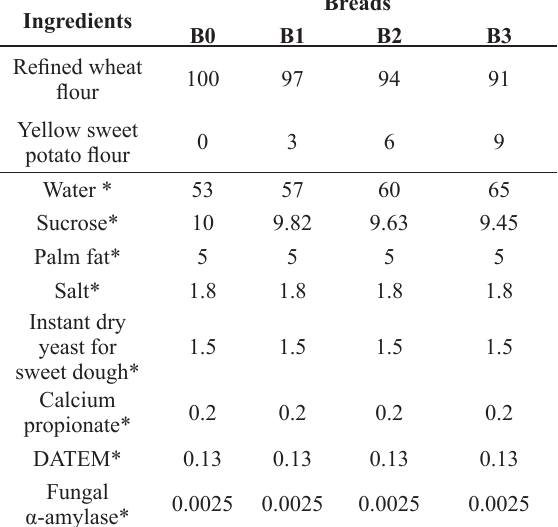
Formulations for the breads with different blends of wheat flour and yellow sweet potato